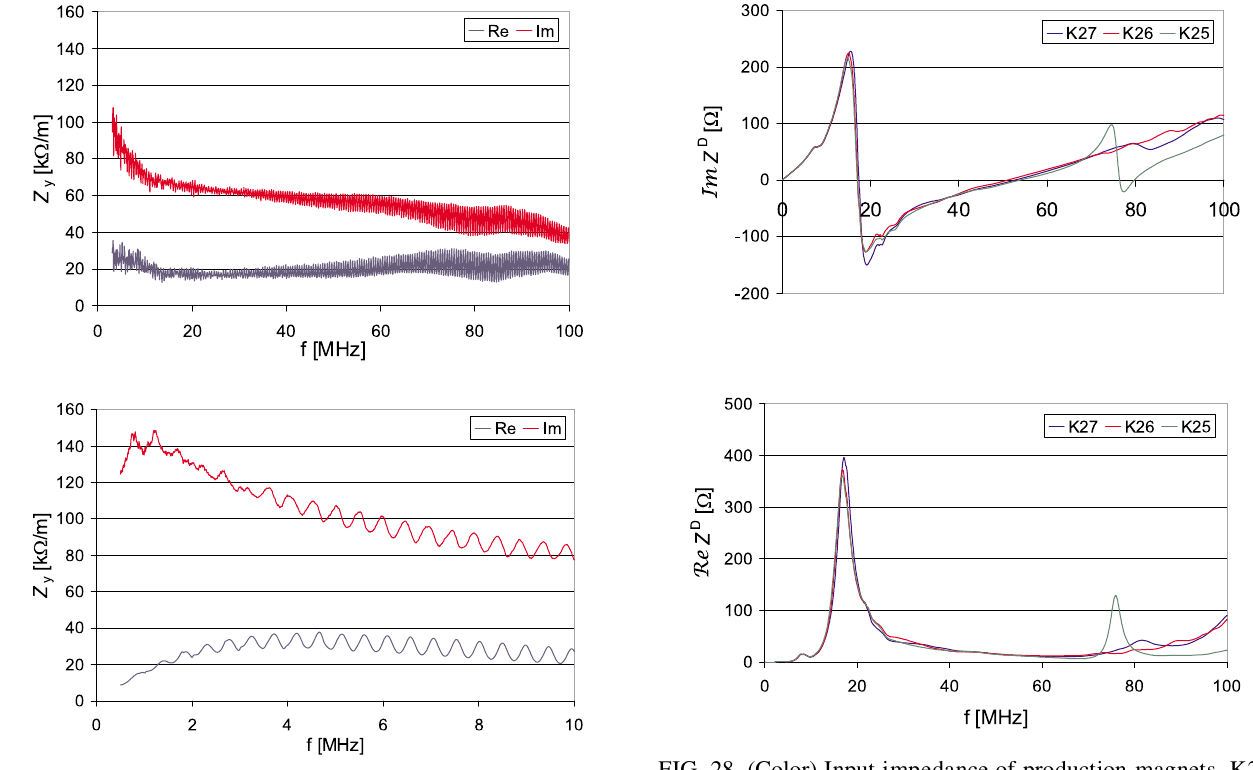
extraction kicker system.